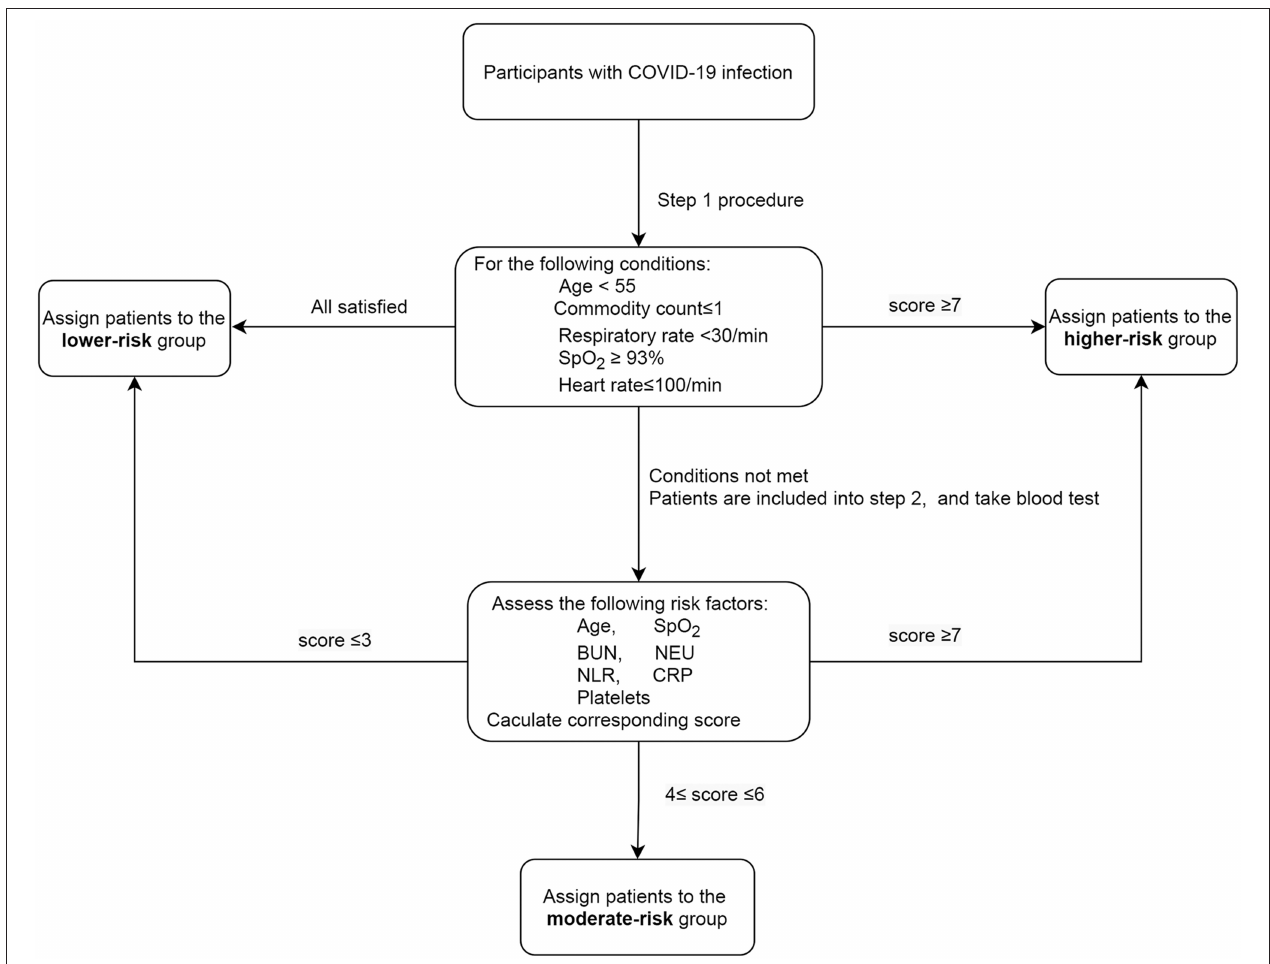
FIGURE 1 | Two-step algorithm for assessing mortality risk from SARS-CoV-2